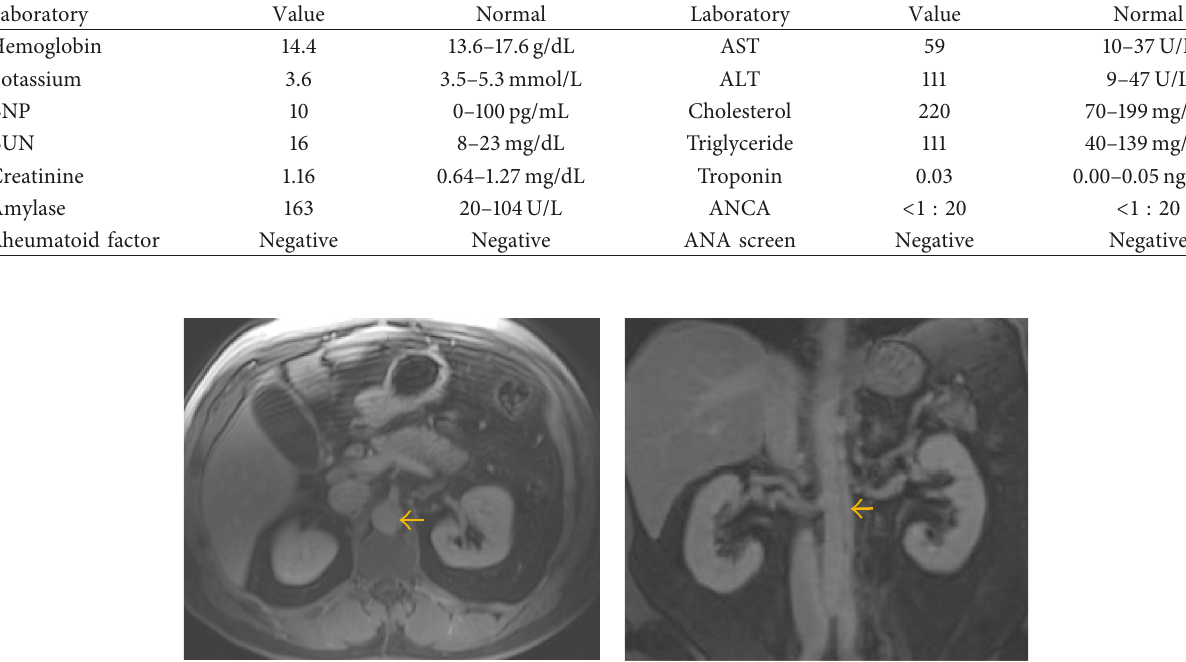
Table 1: Key laboratory investigations on admission.